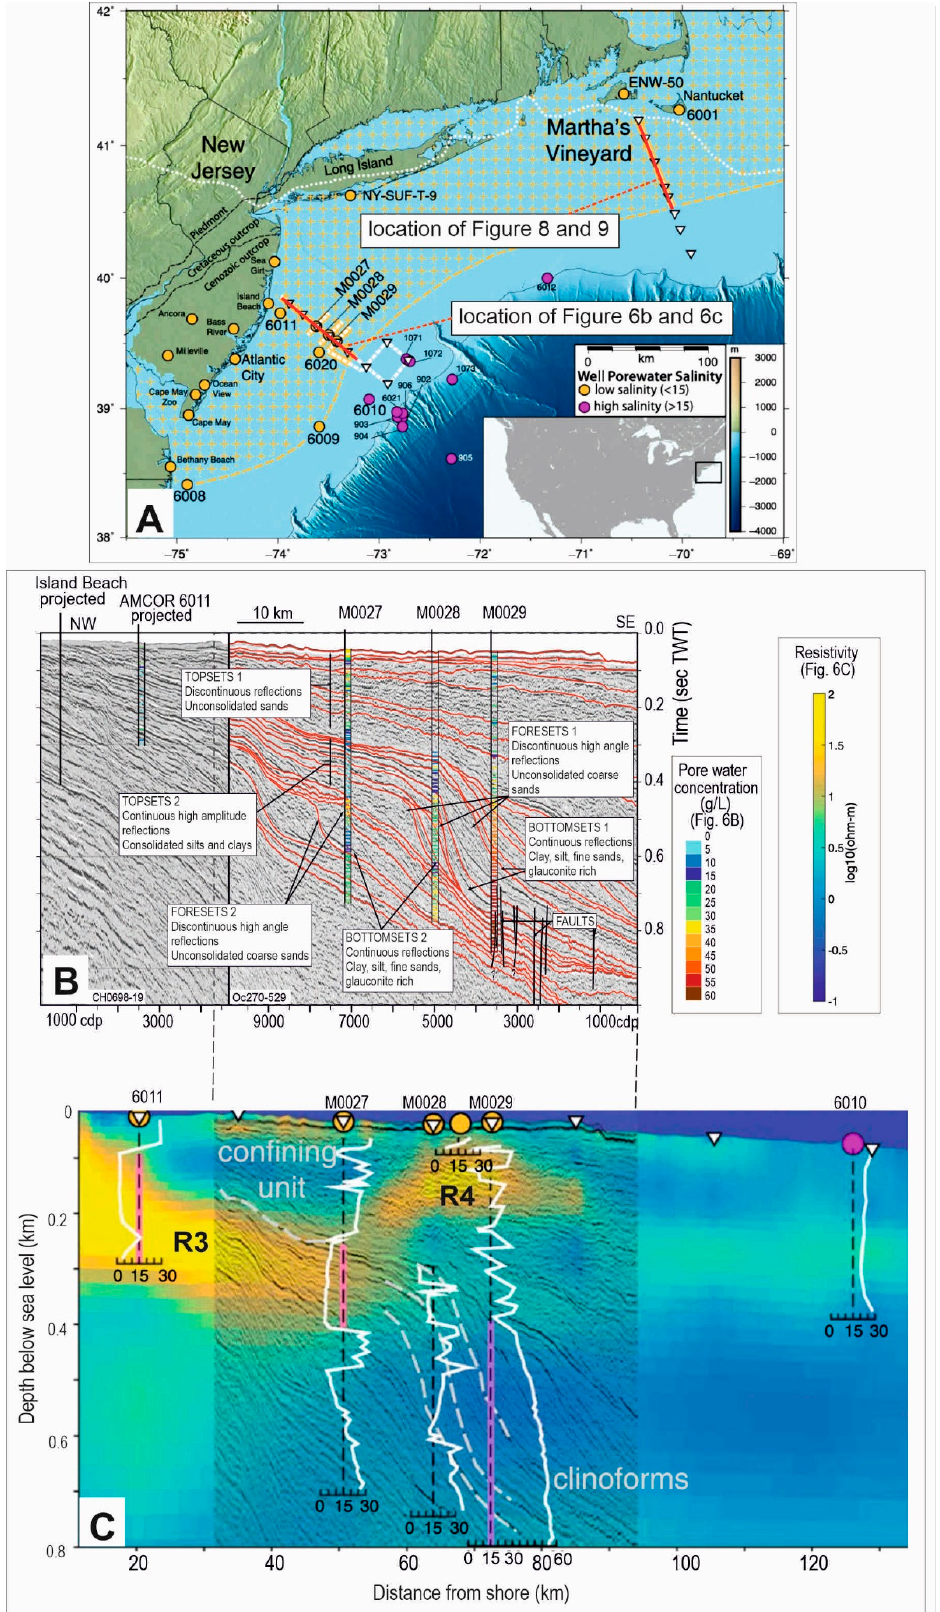
Figure 6. ( A ) Map showing the location of the case studies on the northern North Atlantic continental margin (modified from Reference [98]). Locations of International Ocean Drilling Program (IODP) Expedition 313 boreholes M0027A, M0028A and M0029A are indicated with a white circle and